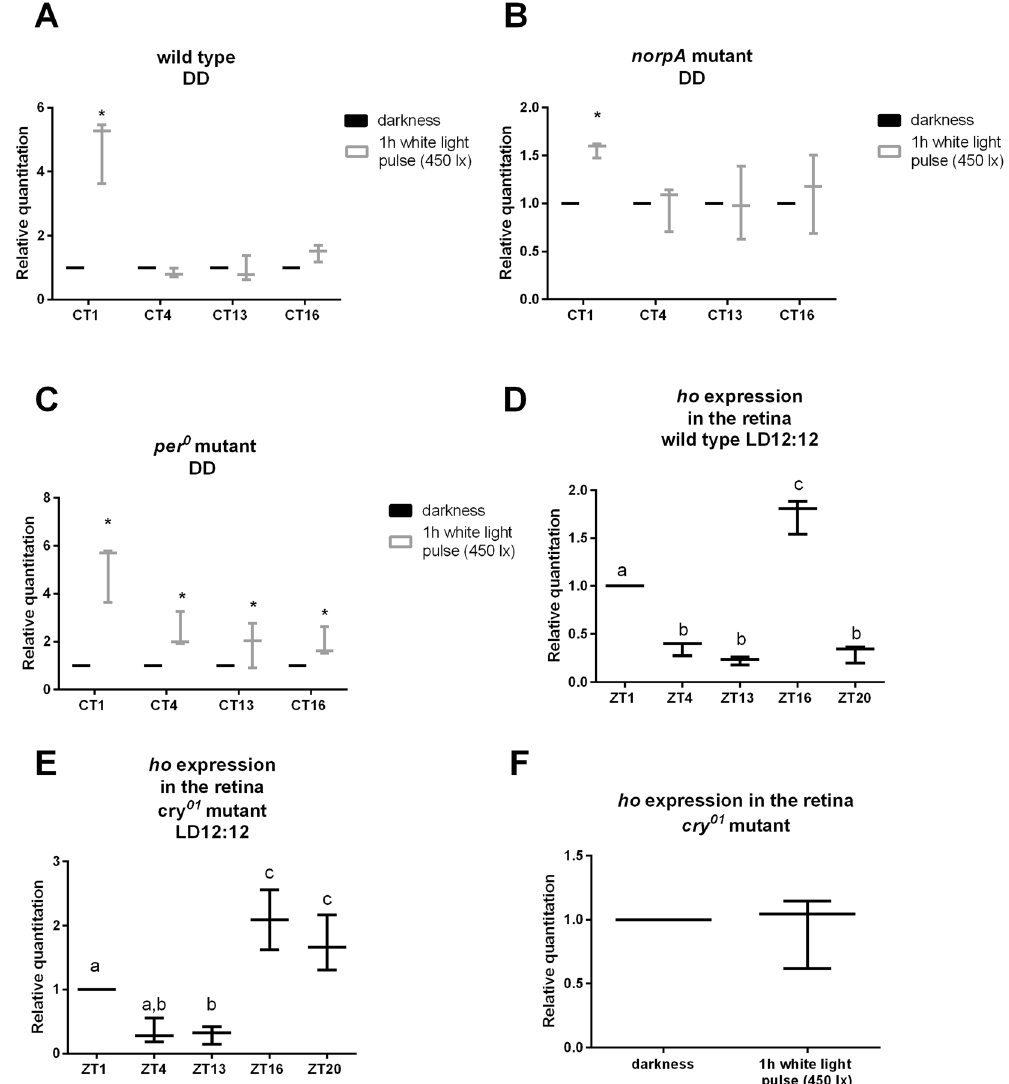
Figure 1. The ho gene mRNA level in the retina of wild type ( A ), norpA ( B ) and per 01 ( C ) mutants after 1 h light exposure in DD at CT1, CT4, CT13 or CT16. Normalization to DD (control) was done at every time point (value = 1.0, horizontal bars). Statistically significant differences are marked with asterisks. ( D , E ) The ho expression in the retina at different time points in light/dark LD12:12 in Canton S ( D ) and cry 01 ( F ). Data are normalized to ZT1. Statistically significant differences are marked with different letters. The same letter above the bars/plots means that there is no statistically significant differences between groups and different letters show significant differences. ( F ) The ho gene expression in cry 01 mutant 1 h after light pulse at CT0. Data are normalized to the control (DD). No statistically significant differences were found. The ends of the vertical bars for each time point represent the range of findings, with the more centrally located horizontal bars the